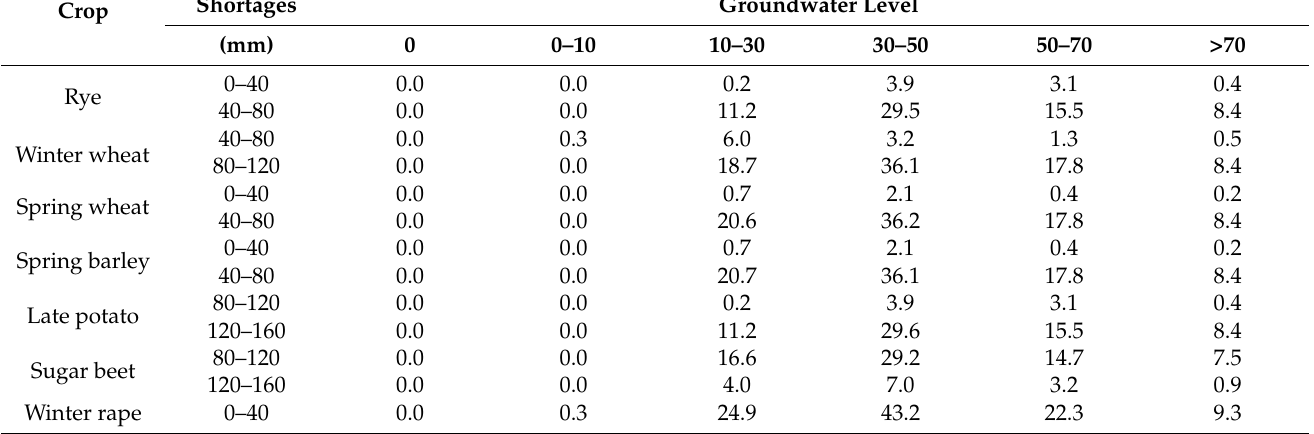
Table 5. Percentage of the area of crops potentially affected by water shortages, with a proba- bility of 20% in the area of groundwater resources in the distinguished performance ranges of a drilled well